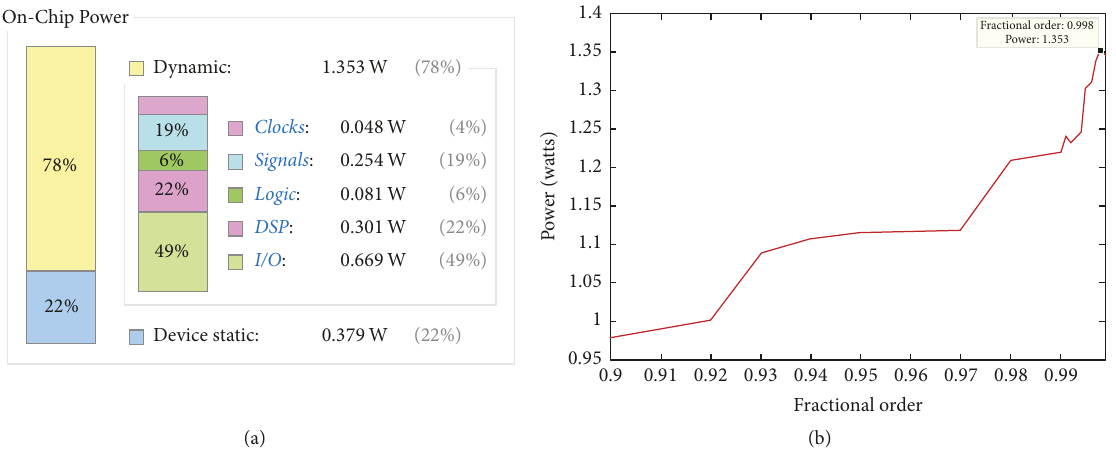
Figure 16: (a) Power utilized and (b) power utilization versus fractional order of FOASMC.